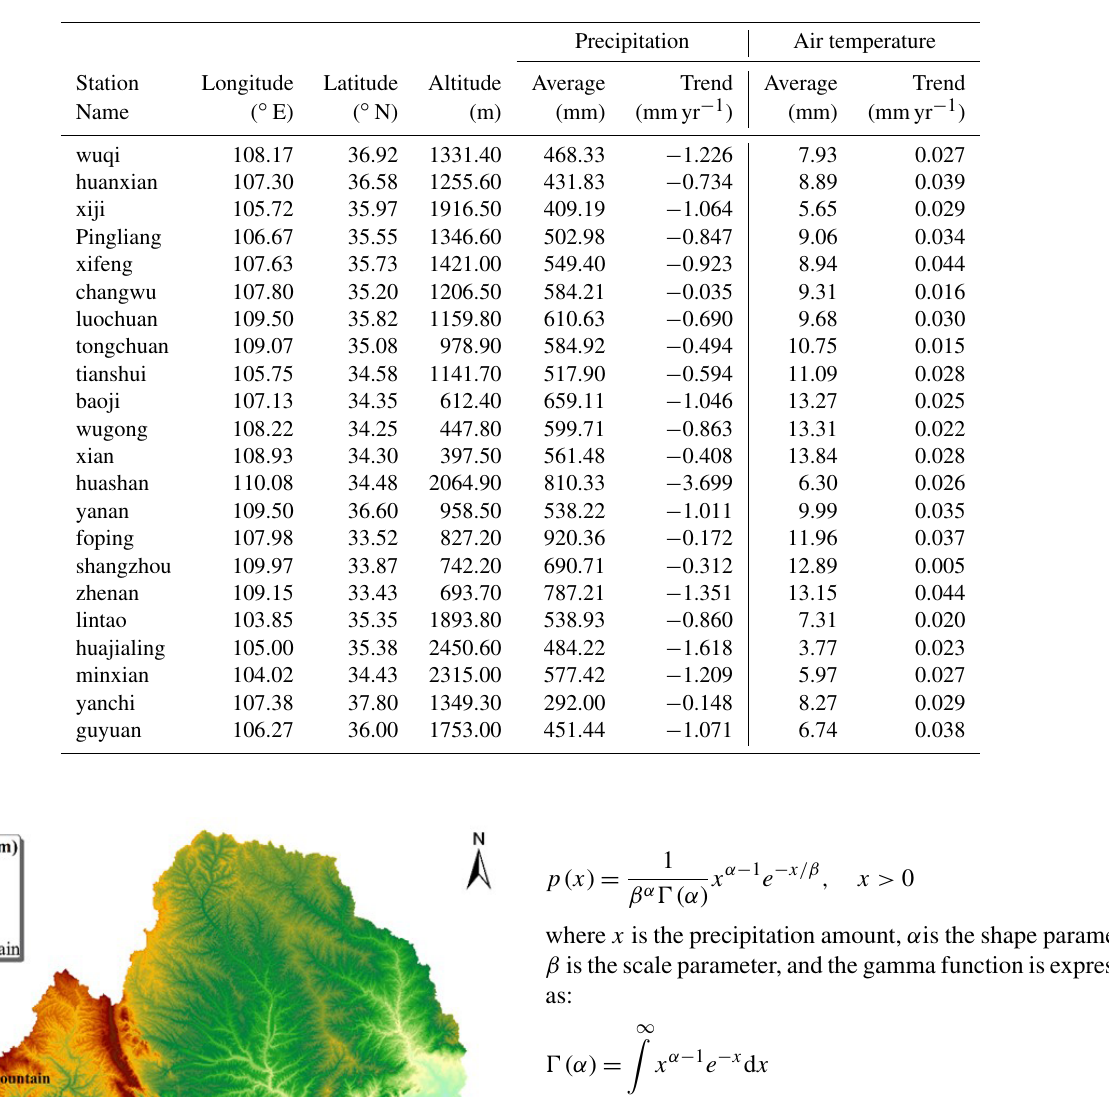
Table 1. The meteorological gauging stations in the Wei River Basin.